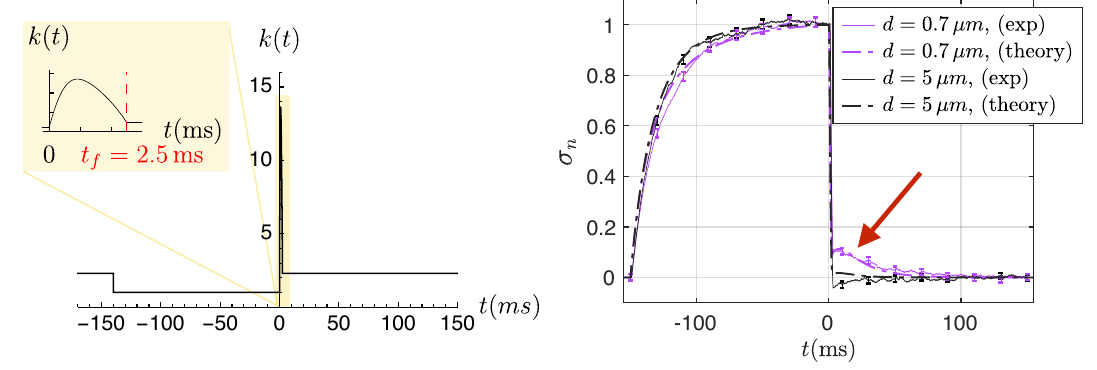
Figure 2: On the left, the stiffness profile applied to both wells: a STEP decompres- sion at t = − 140ms followed by a basic ESE protocol for compression for 0 < t < t . f This procedure is called the symmetric protocol . At t = − 140ms, the stiffness jumps = 2.3 to k = 1. At t = 0 the particle is thus in its initial equilibrium when we from k f i apply an ESE protocol finishing at t to bring back the particle to its final state at k . f f = 2.5ms, K = 4 × 10 − 7 N / m, k = 2.3, and Γ = 18.9. The ESE parameters are: t f i f This stiffness profile emphasizes the difference between the relaxation after a step function, and the response to the ESE protocol. On the right, normalized variance of = ( σ ( t ) − σ ) / ( σ − σ ) , corresponding to the symmetric pro- the first particle σ n f i f tocol on the left. The plain lines are the experimental results with their error bars. The dashed curves are numerically computed from the theoretical analysis of section 4, plugging the experimental parameters from the calibration. The same process is applied for particles separated by d = 5 µ m (black) and d = 0.7 µ m (purple) corre- sponding respectively to a coupling constant (introduced in section 4) ε = 0.21 and ε = 0.5. A small rebound (around 10% of the step) pointed by the red arrow and long relaxation time are visible for close